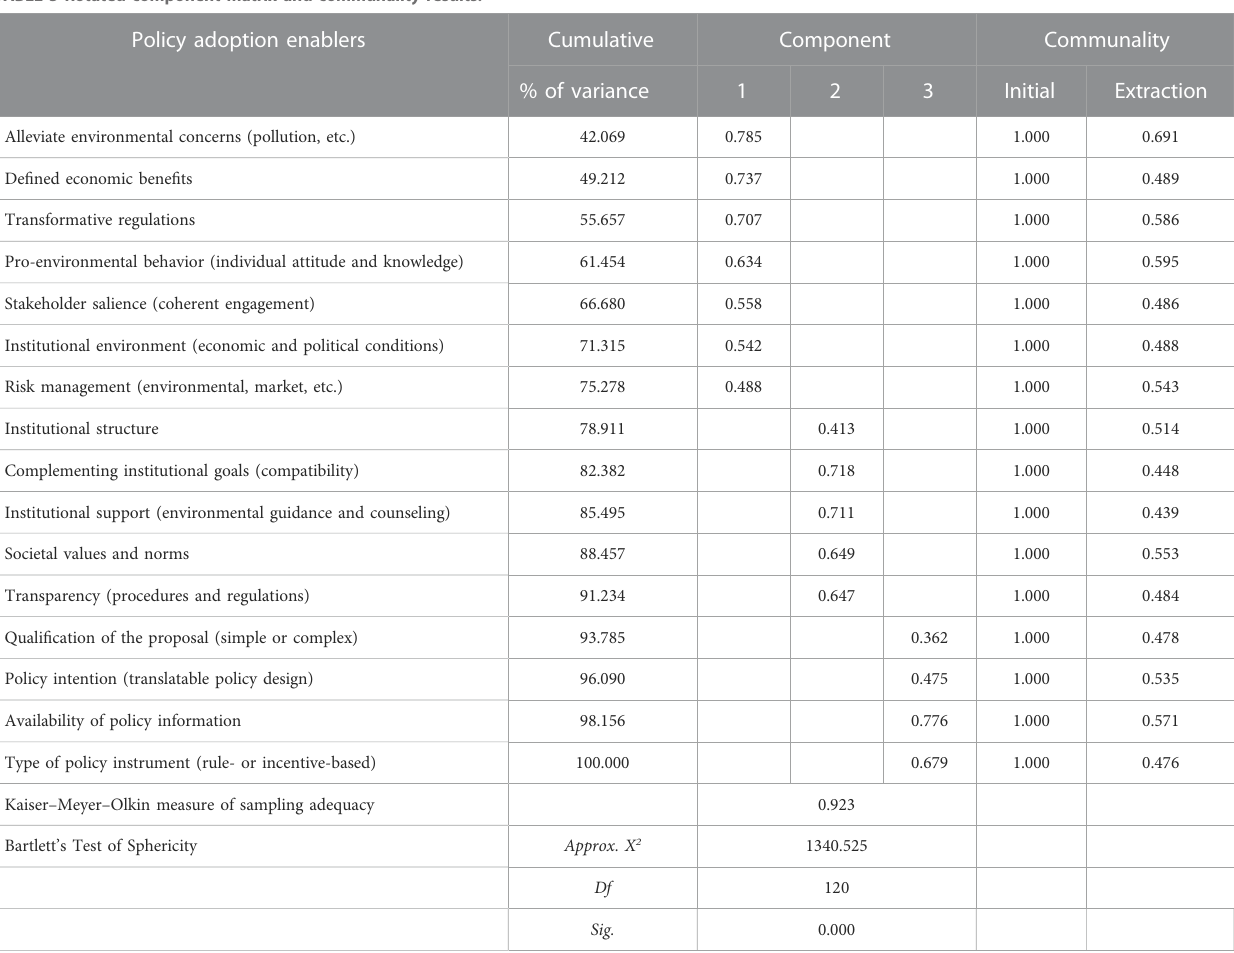
TABLE 5 Rotated component matrix and communality results.